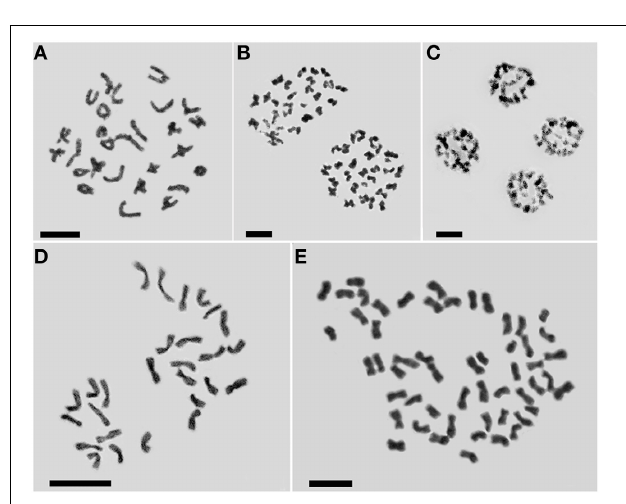
FIGURE 1 | Thegerminationof A.frutescens pollenonthe C.morifolium stigmaimagedat(A)6h,(B)12h,(C)24h,(D)36h,and(E)48hpostpollinationand callusdevelopmentfromnon-fertilized, invitro cultured C.morifolium ovules.(F) ovules, (G) formationofcallus, (H) formationofplantlets.Bar (A–E) :100 μ m.